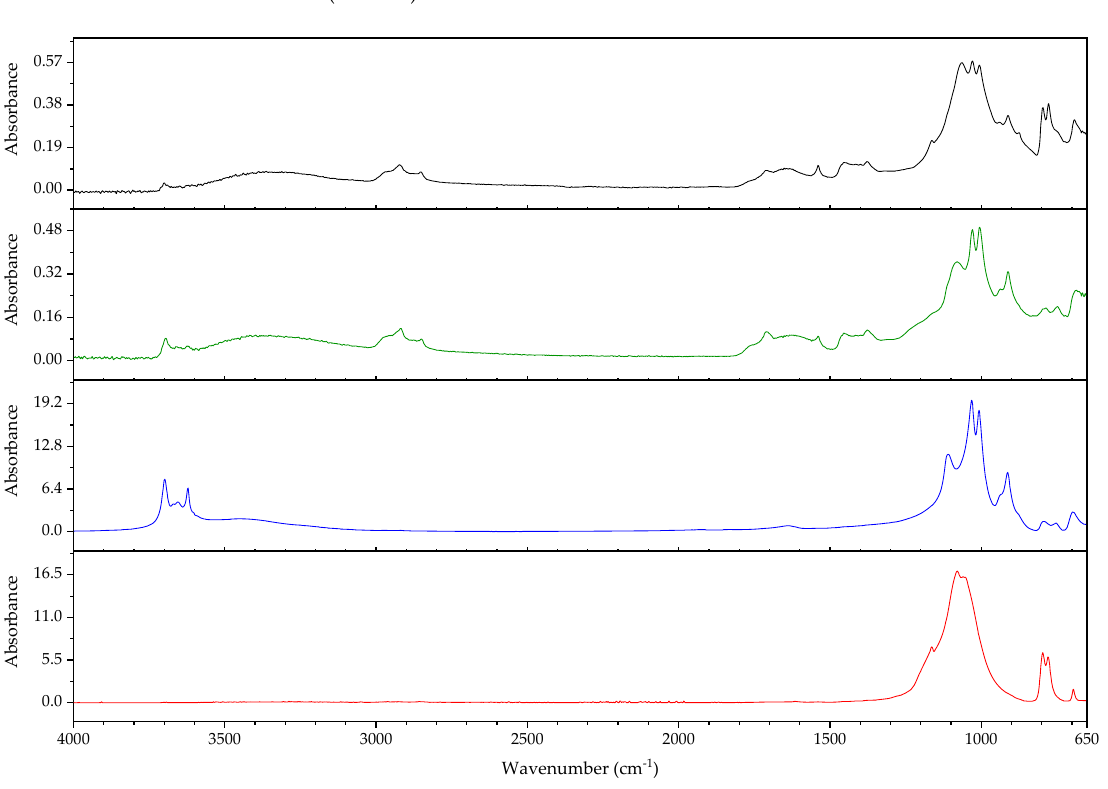
Figure 4. FTIR spectra of samples 194 (black line) and 598 (green line) compared to reference spectra of clay (blue line) and quartz (red line) from a commercial database.